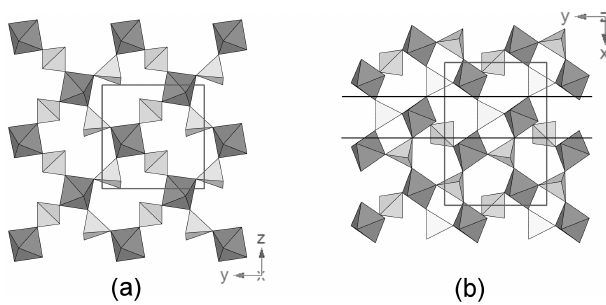
Figure 6. (a) Structural layer in Fe 2 ( MoO 4 ) 3 , as seen down [100]; (b) connection of layers as in (a) , as seen down